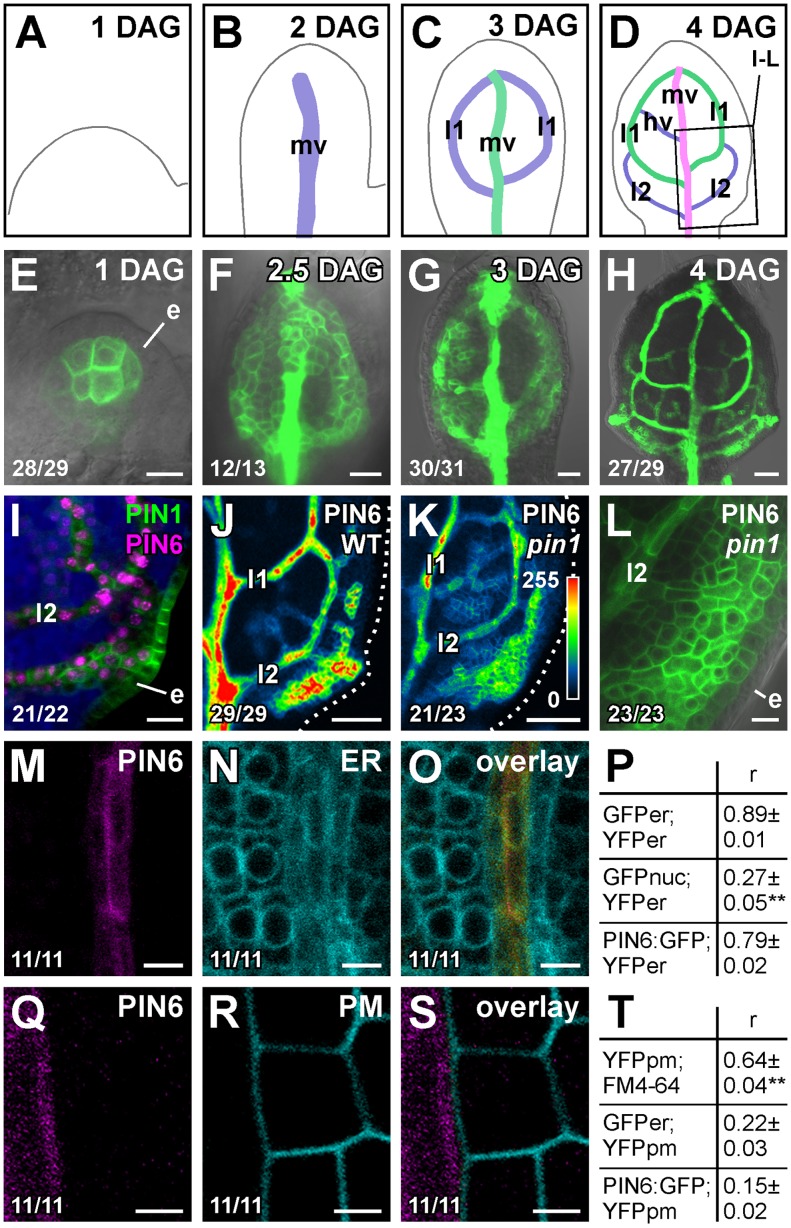
PIN6 expression in leaf development.(A–O,Q–S) Top right: leaf age in days after germination (DAG), marker and genotype. Bottom left: reproducibility index. First leaves. (A–D) Midvein, loops and minor veins differentiate progressively later in the same region of the developing leaf, and loops and minor veins differentiate in a tip-to-base sequence during leaf development [6], [7], [57]; purple, green and magenta: successive stages of vein differentiation. Box in (D) illustrates position of close-ups in (I–L). (E–O,Q–S) Confocal laser scanning microscopy with (E–H,L) or without (I–K,M–O,Q–S) transmitted light. (E–H) PIN6::PIN6:GFP expression. (I) Expression of PIN6::YFPnuc and PIN1:PIN1:CFP at 4 DAG; blue: chlorophyll. (J–L) PIN6::PIN6:GFP expression in WT (J) and pin1 (K,L) at 4 DAG. LUT (in K) visualizes expression levels. Dotted line: leaf outline. (M–O,Q–S) Expression of PIN6::PIN6:GFP (M,Q), 35S::YFPer (N), 35S::LTI6B:YFP (R) and respective overlays displayed with a dual-channel LUT [66] (O,S): prevalence of cyan over colocalized magenta signal is shown in green, opposite in red, and colocalized cyan and magenta signals of equal intensity in yellow. (P,T) Quantification of colocalized GFP and YFP signals (as mean ± SE of Manders' coefficient ‘r’) in populations (n = 11) of positive controls: J1721::GFPer;35S::YFPer (P), 35S::YFPpm;FM4-64 (T); negative controls: ATHB8::GFPnuc;35S::YFPer (P), J1721::GFPer; 35S::YFPpm (T); and samples: PIN6::PIN6:GFP;35S::YFPer (P), PIN6::PIN6:GFP; 35S::YFPpm (T). (P) Difference between negative control and positive control, and between negative control and sample was significant at P<0.01 (**) by one-way ANOVA and Tukey's test. (T) Difference between positive control and negative control, and between positive control and sample was significant at P<0.01 (**) by one-way ANOVA and Tukey's test. e, epidermis; hv, minor vein; l1, first loop; l2, second loop; mv, midvein. Bars: (E,I,L) 10 µm; (F,G) 20 µm; (H,J,K) 50 µm; (M–O) 5 µm; (Q–S) 2.5 µm.